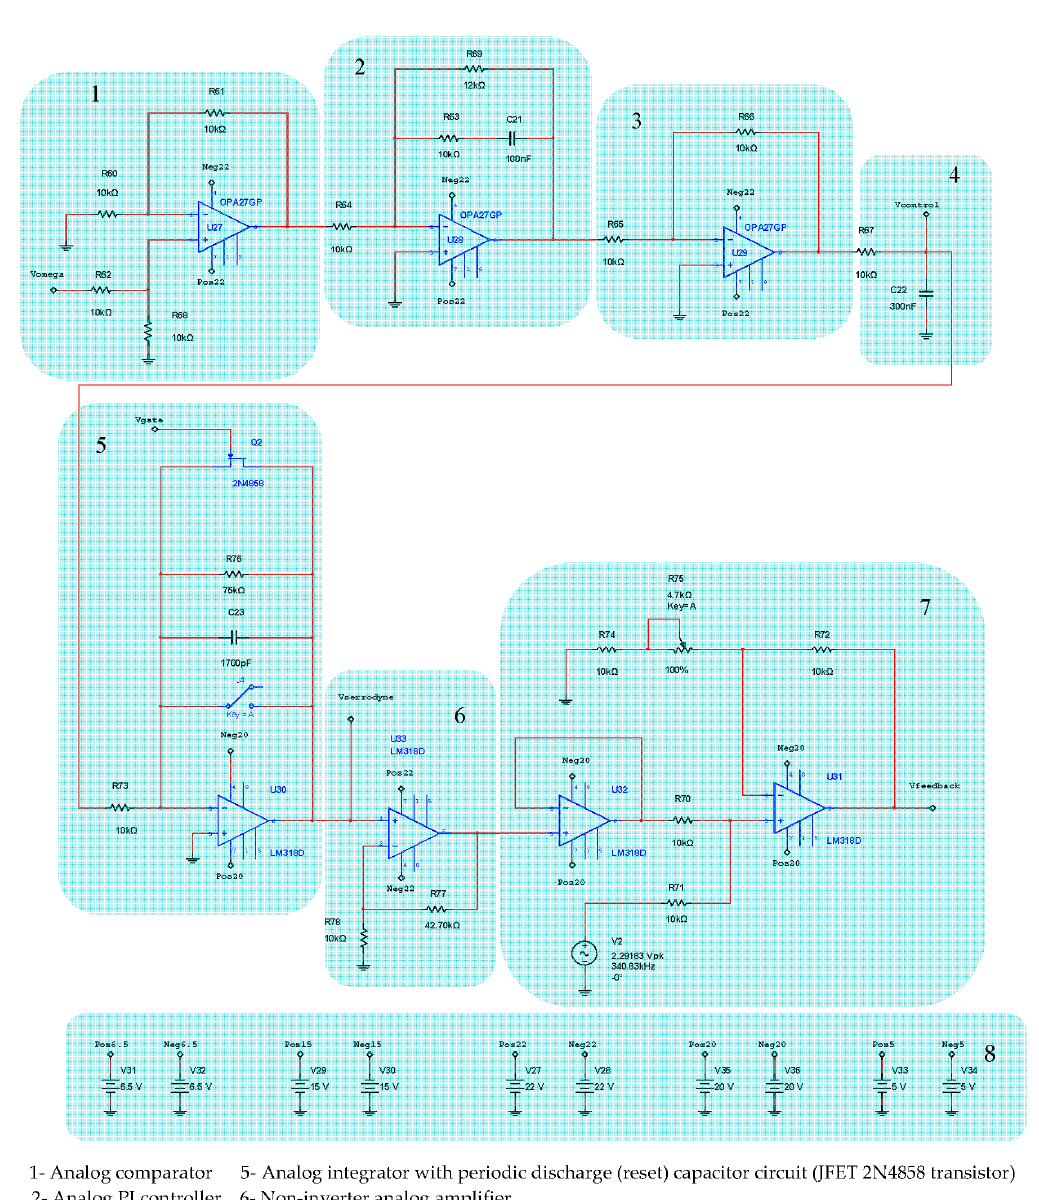
Figure 5. Analog controller circuit (includes blocks #1, #2, #3 and #4) and serrodyne feedback phase-modulation circuit (includes blocks # 5, #6 and #7).